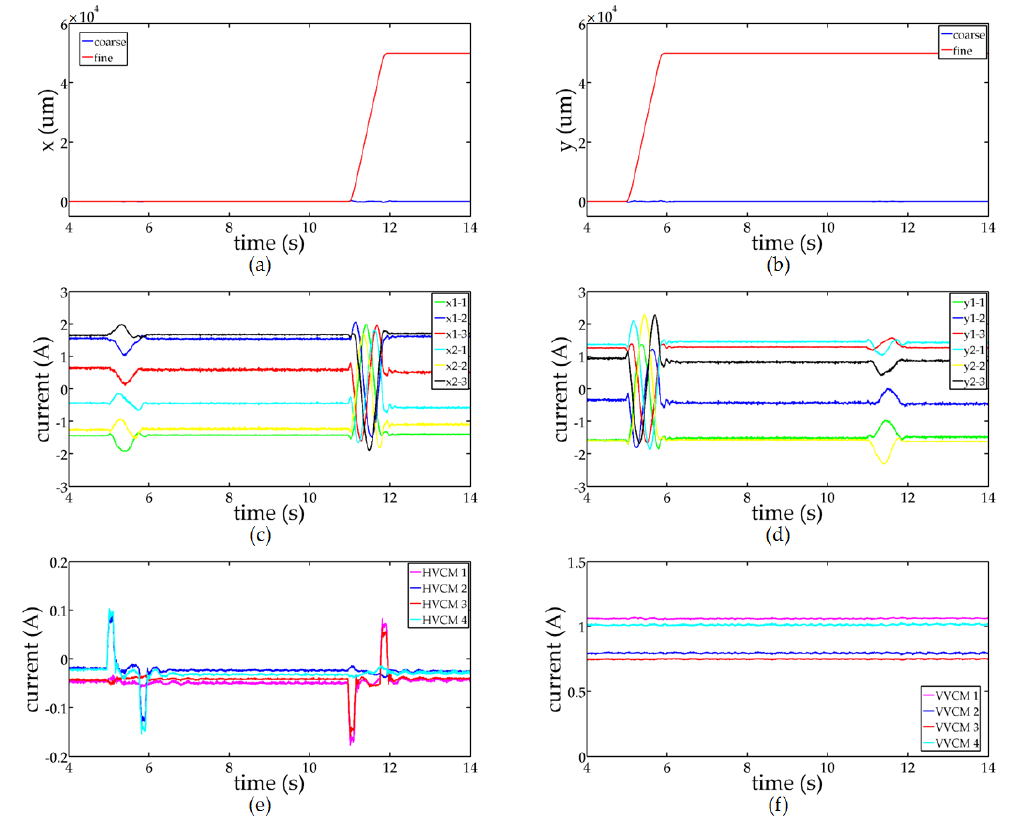
Figure 13. The evaluated settling time data of the dual servo stage: ( a ) x direction, ( b ) y direction.